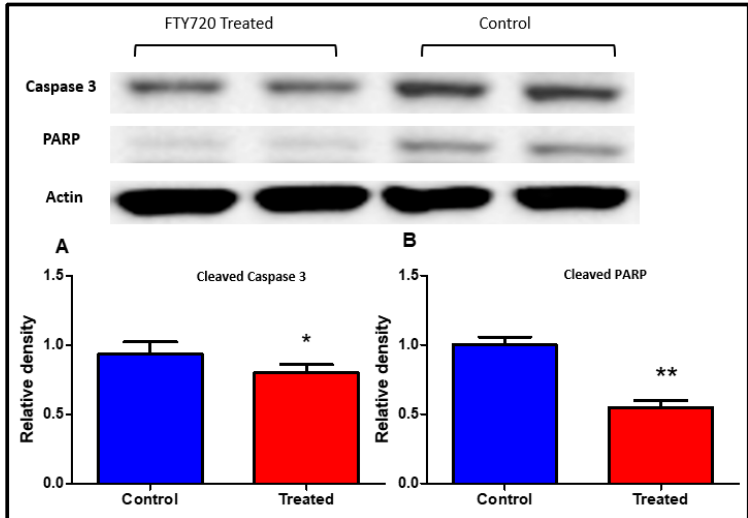
Figure 5. Cleaved caspase-3 and PARP protein expressions in myocardial tissue analyzed using Western blot. ( A , B ) Relative densities of cleaved caspase-3 and PARP protein levels. Data presented as a mean ± SD. p -value < 0.05 considered as significant. ( ∗ p < 0.05 and ∗∗ p < 0.001, treated vs. control).